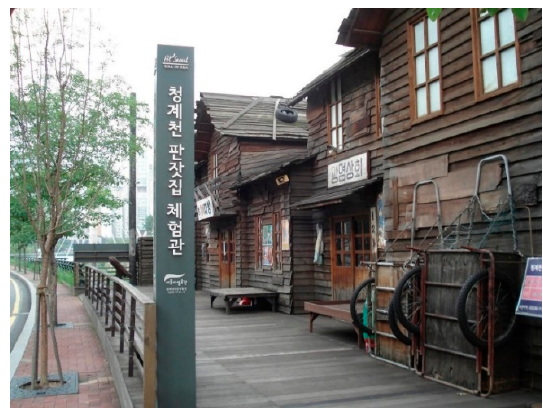
Figure 19. Replica of a Cheonggyecheon shanty.